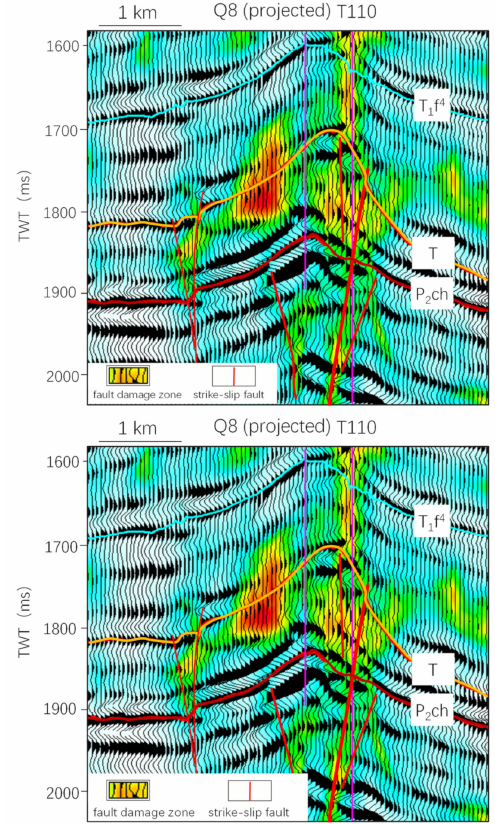
Figure 8. Seismic section with the energy parameter (green-orange color), showing the fault damage zone overlapping the reef–shoal along the Permian platform margin (T 1 f 4 : the fourth member of the Lower Triassic Feixianguan Formation; P 2 ch: the upper Permian Changxing Formation).